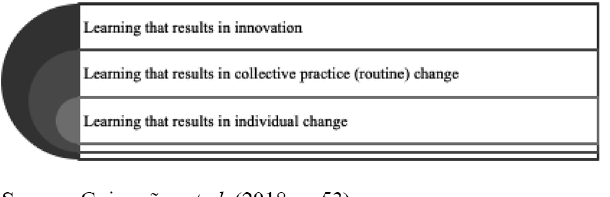
Figure 1. Outcome space –